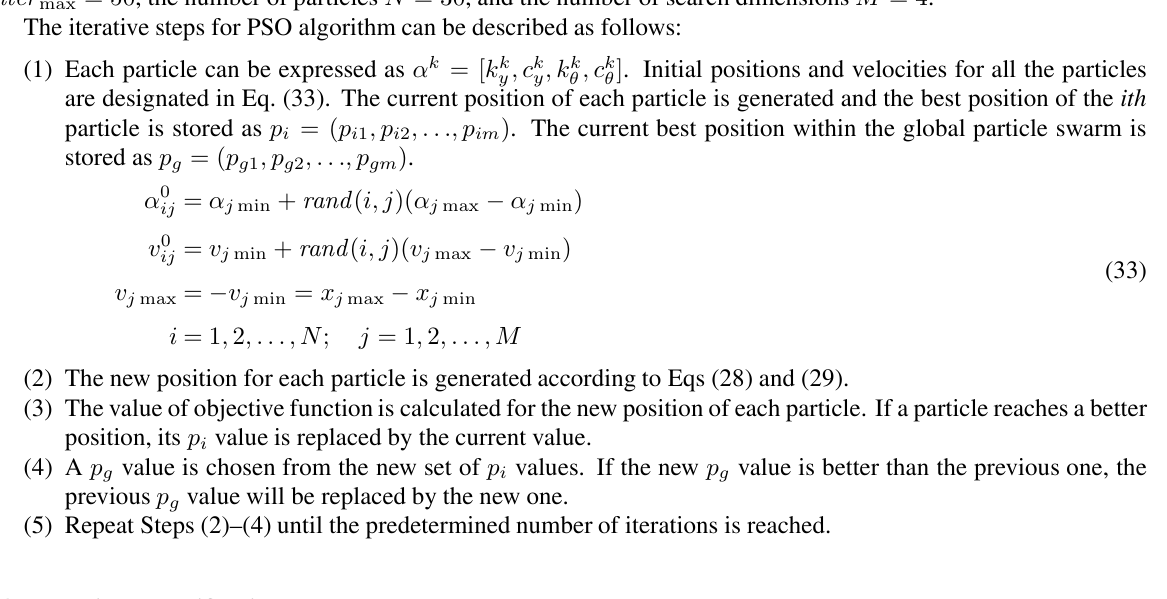
c c iter 1 and 2 , respectively. max is the